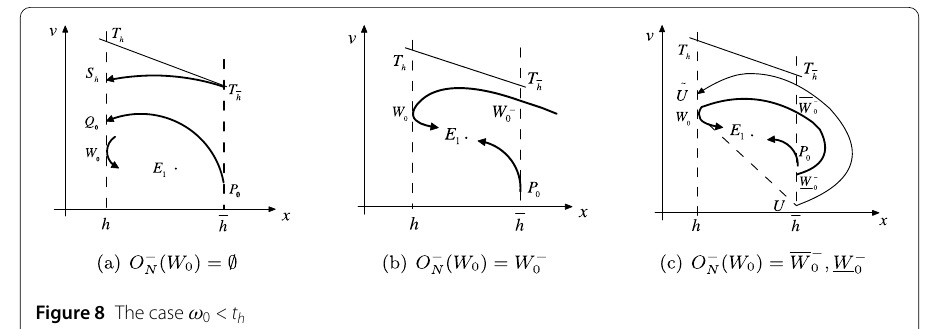
Figure 8 The case ω 0 < t